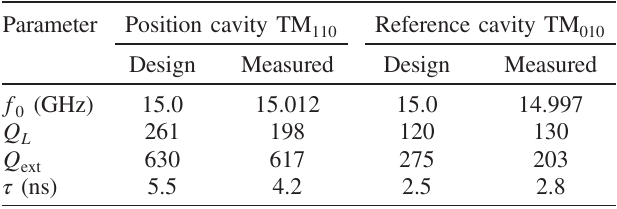
TABLE II. Parameters of the resonant cavity modes in the cavity BPM pickup as measured using a network analyzer in comparison to those predicted from simulation